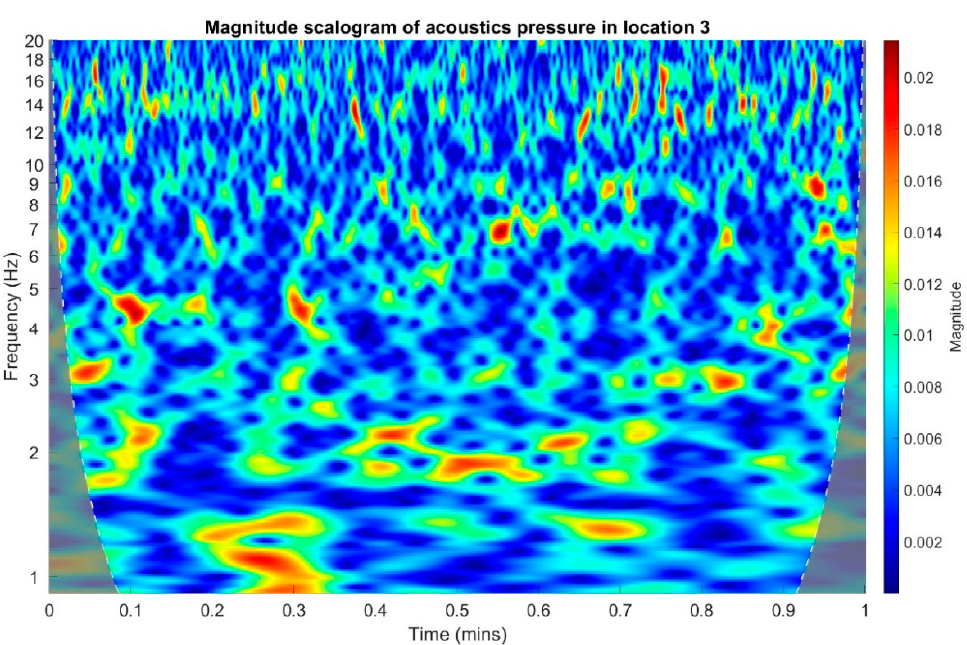
Figure 22. Magnitude scalogram of acoustic pressure in location 3.